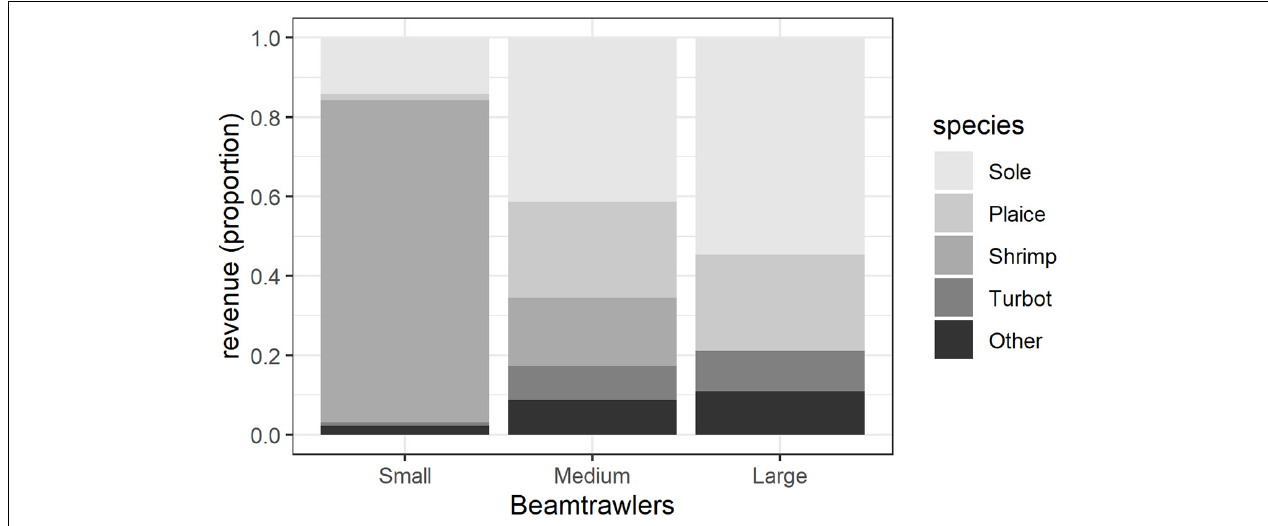
FIGURE 3 | Landings composition of the three Dutch flatfish and shrimp beam trawling fleets in value (2013–2015 data source STECF,